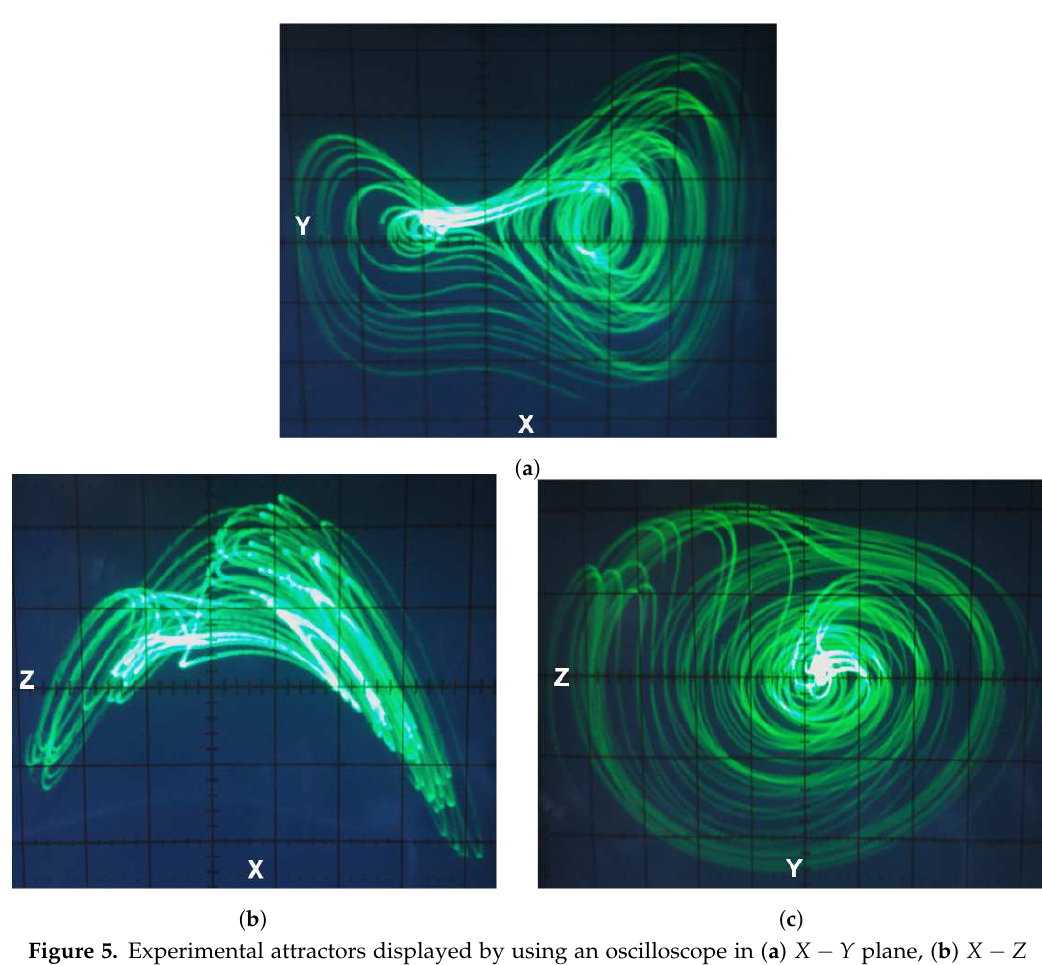
Figure 5. Experimental attractors displayed by using an oscilloscope in ( a ) X − Y plane, ( b ) X − Z plane, and ( c ) Y − Z